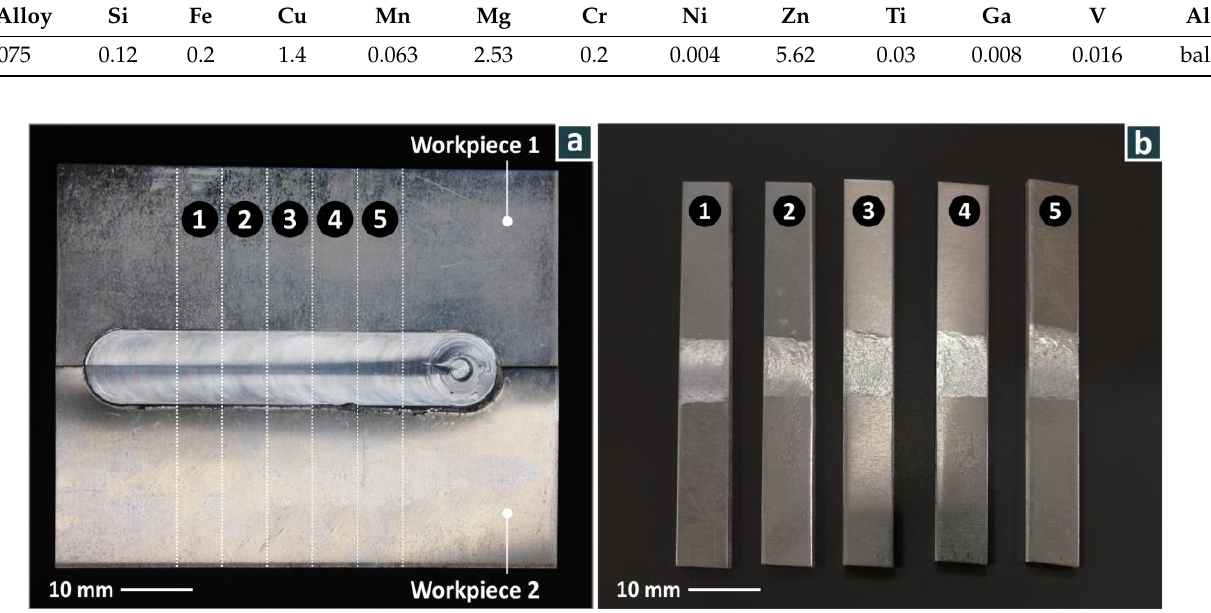
Figure 4. ( a ) Welded specimen with tensile test coupons. ( b ) Typical coupons for mechanical strength measurement after they were cut from the welded plate. Numbers indicate the number of each sample in the tests.